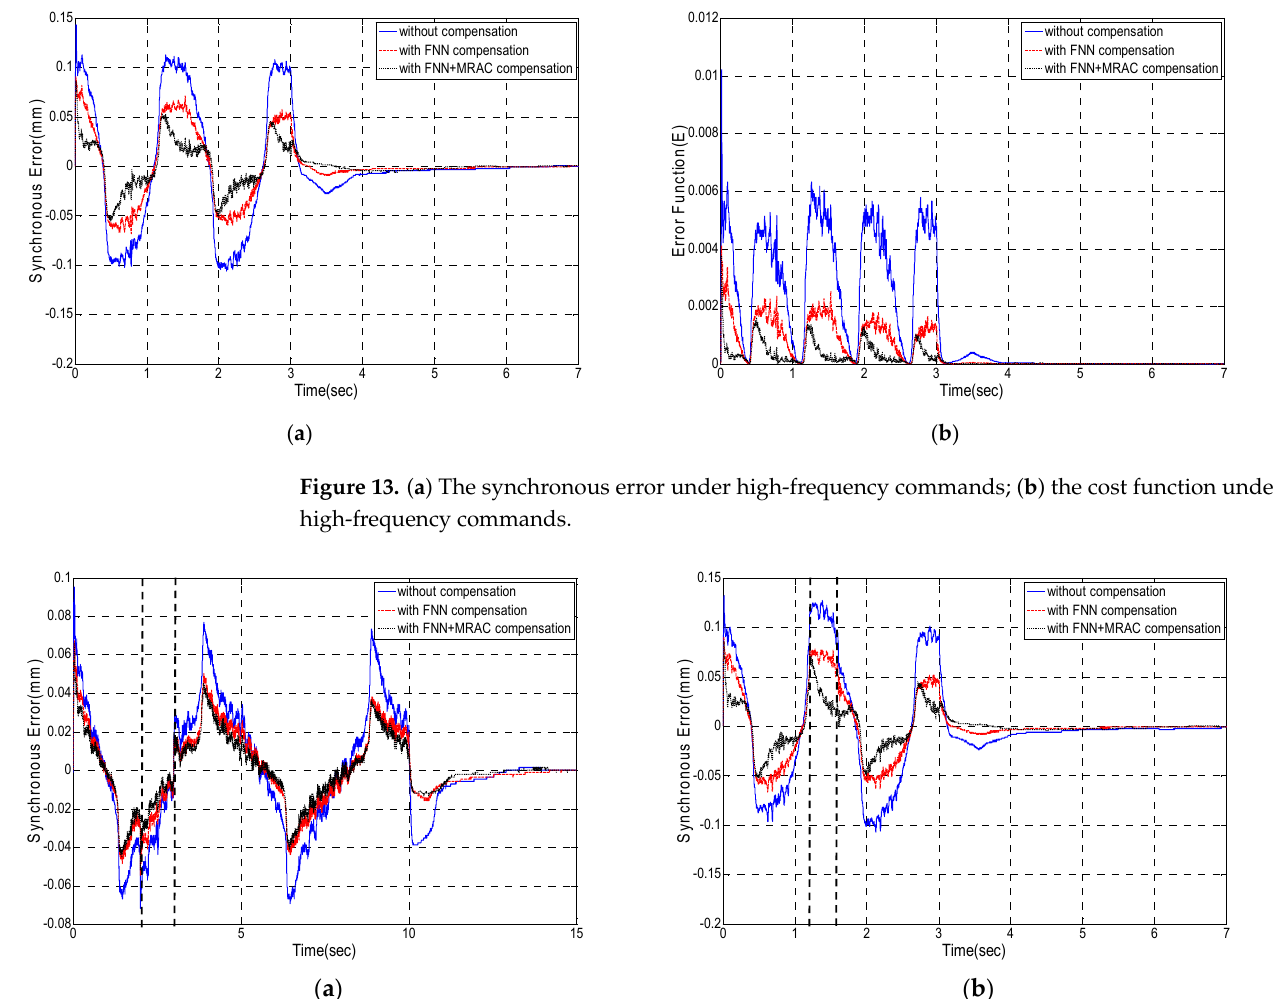
Figure 12. ( a ) The synchronous error under low-frequency commands; ( b ) the cost function under low-frequency commands.